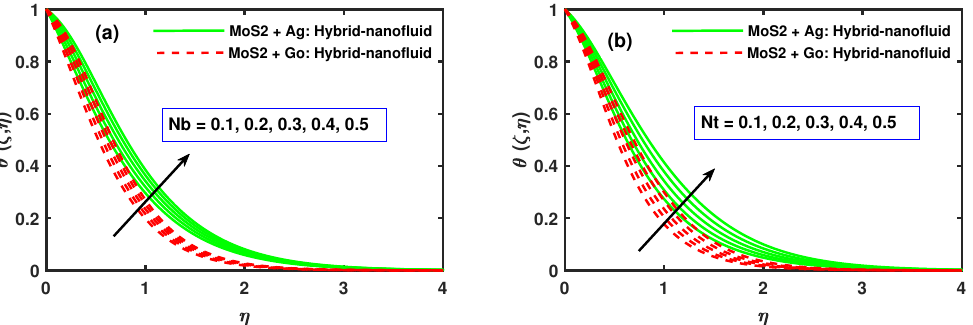
Figure 6. Fluctuation of θ ( ζ , η ) along with Nb (Brownian motion) and Nt (thermophoresis) at ζ =